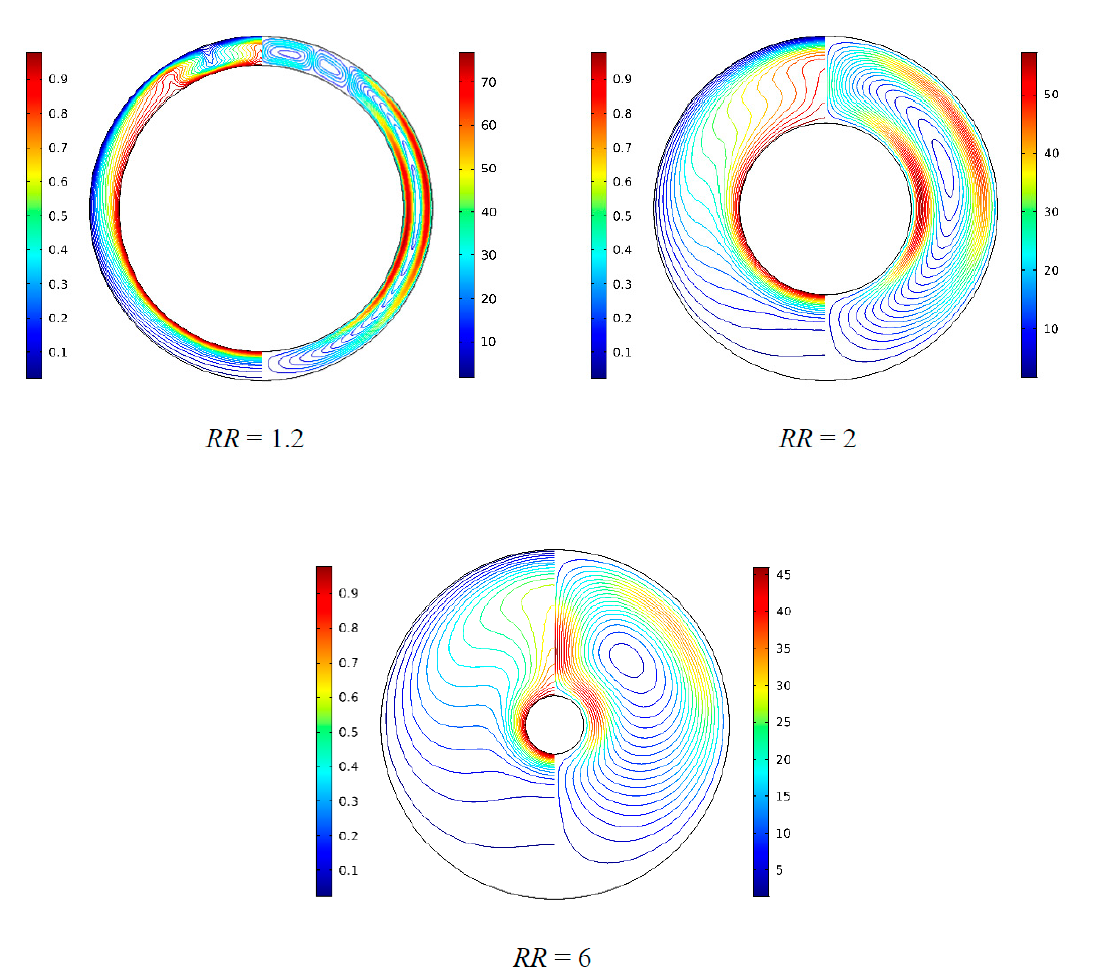
Figure 19. Isotherms (left) and streamlines (right) for Cu–water nanofluid for different radius ratios ( RR ) at Ra = 5 × 10 4 , Da = 10 − 2 , φ = 0.05, d sp = 50 nm, and ε = 0.5.